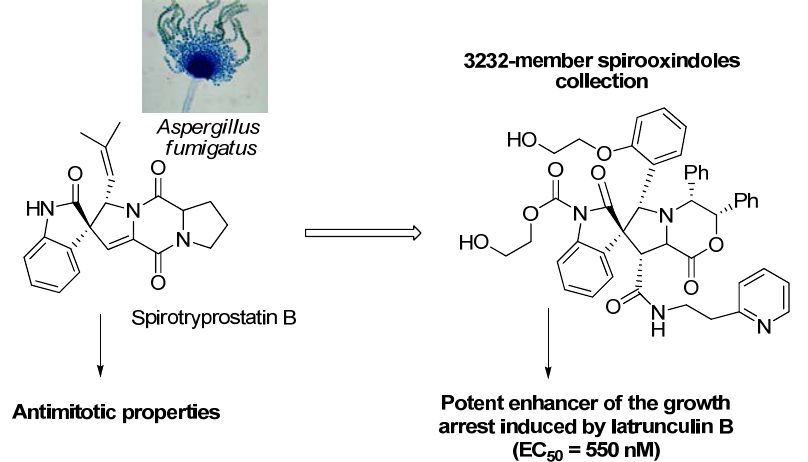
Figure 9. New spirooxindole collection inspired by the spirotryprostatin B structure.